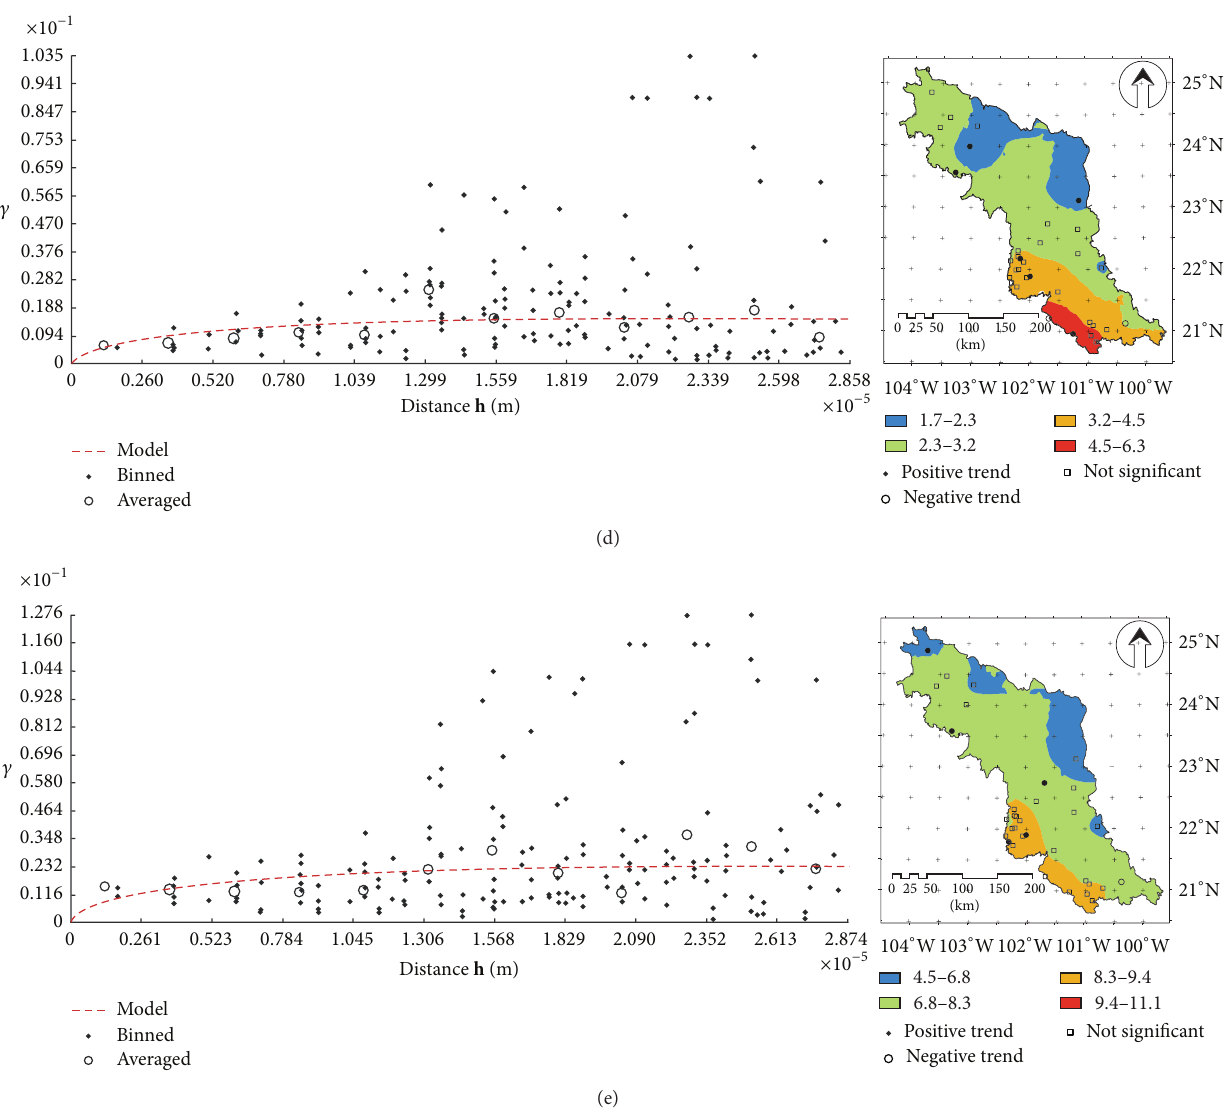
Figure 2: Semivariograms and geostatistical surface map layers of significant indices. (a) = PRCPTOT; (b) = R10mm; (c) = R20mm; (d) = R25 mm; and (e) = SDII.